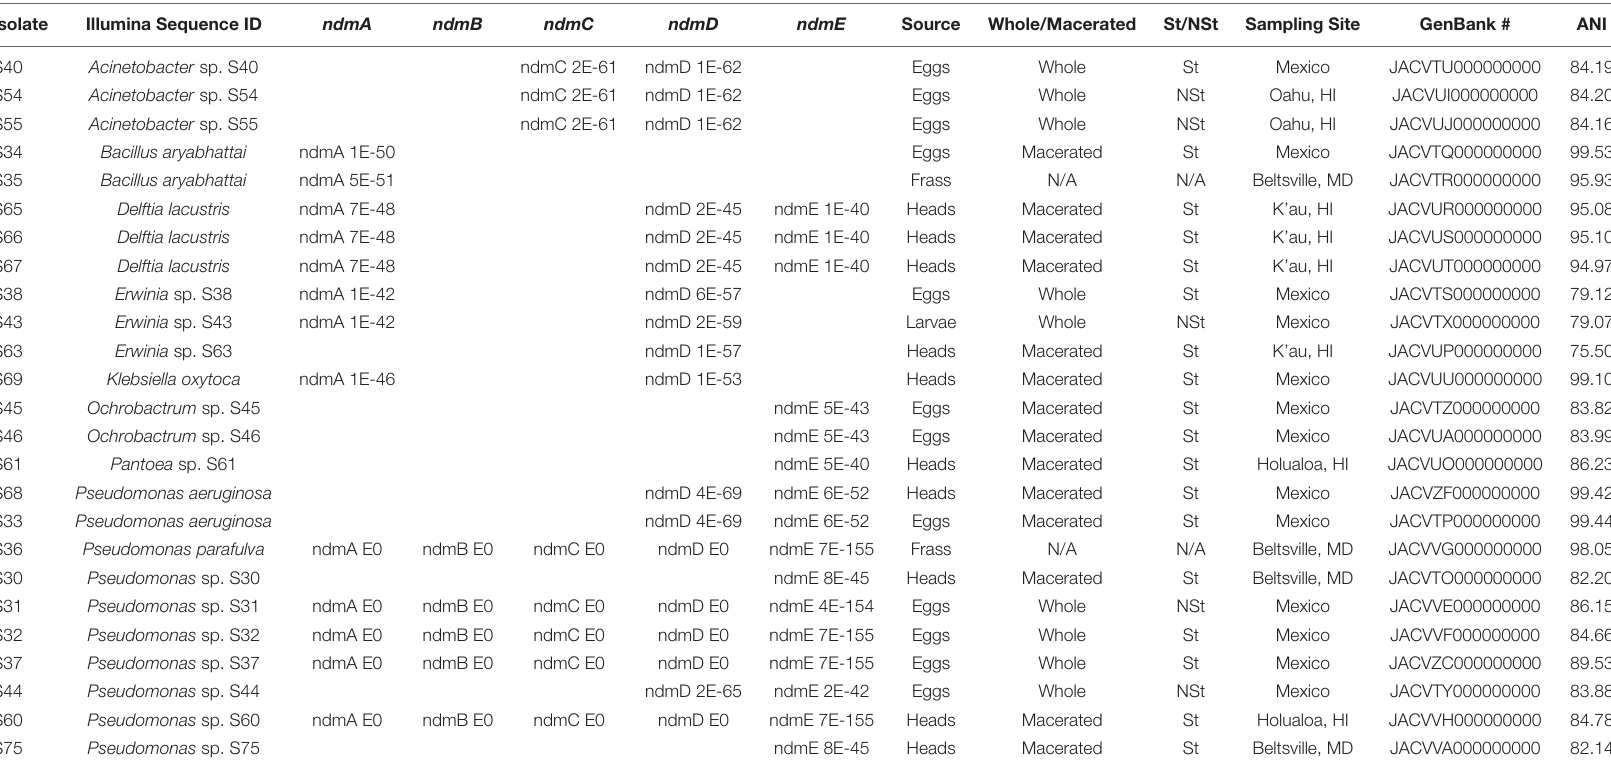
TABLE 1 | Bacterial identification based on Illumina sequence, with GenBank E -values for genes involved in the caffeine N-demethylation pathway ( ndmA , ndmB , ndmC , ndmD , ndmE ), coffee berry borer source used for bacterial isolation (eggs, frass, heads, larvae), non-macerated (whole) or macerated tissue, sterile (St) or non-sterile (NSt), sampling site, GenBank accession numbers, and average nucleotide identity (ANI; Chun et al., 2018)